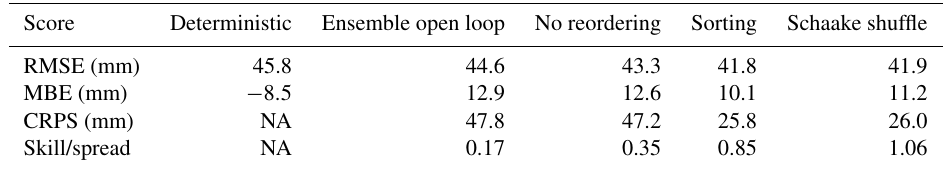
Table 2. Scores averaged over the 50% validation snow